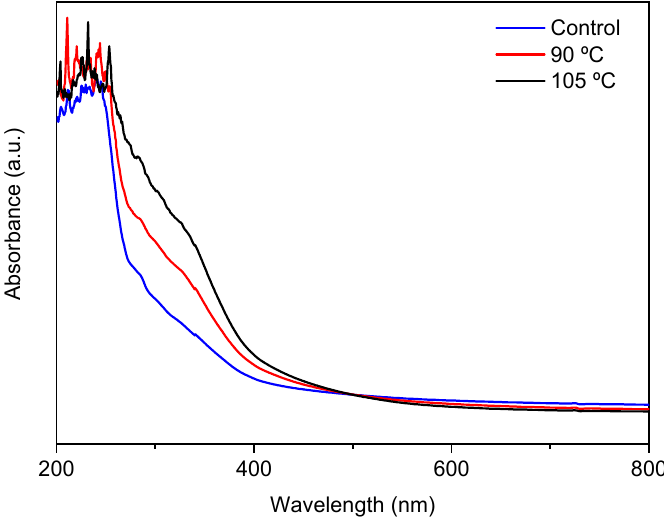
Figure 6. UV-vis spectra of control and thermally treated films.